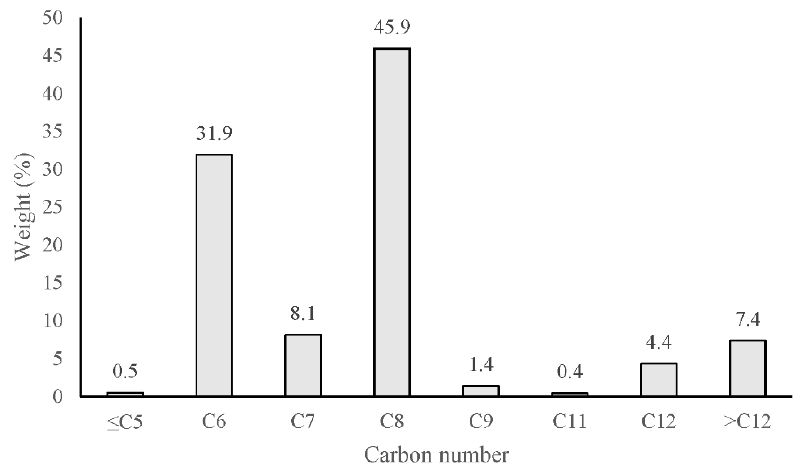
Figure 9. Hydrocarbon composition (by number of carbons) of isothermal pyrolysis condensate.